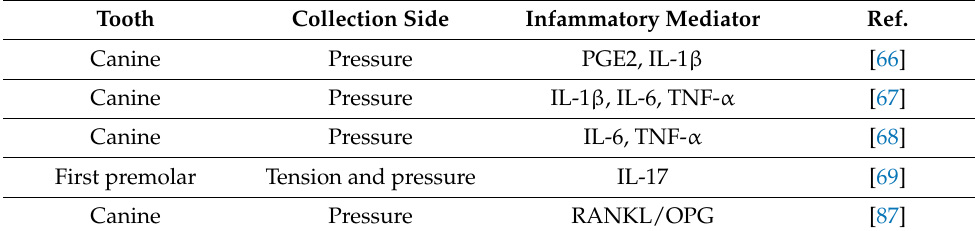
Table 3. Human GCF studies in inflammation and orthodontic tooth movement.